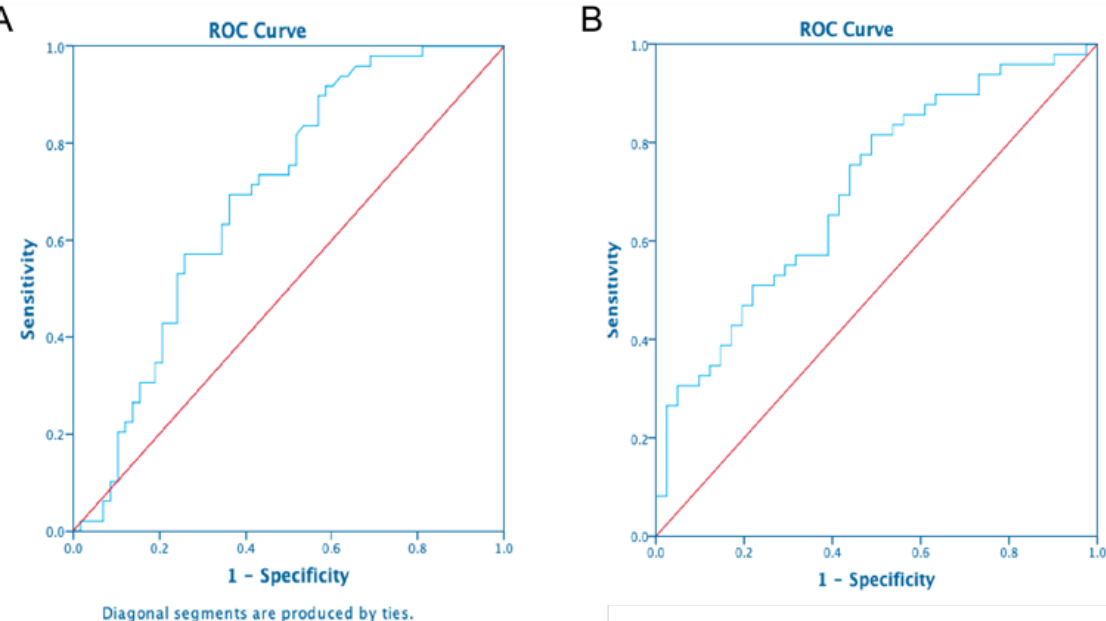
Figure 3. ( A ) Receiver operating characteristics (ROC) curve between lung cancer and benign nodules, (B) Receiver operating characteristics (ROC) curve between lung cancer and controls